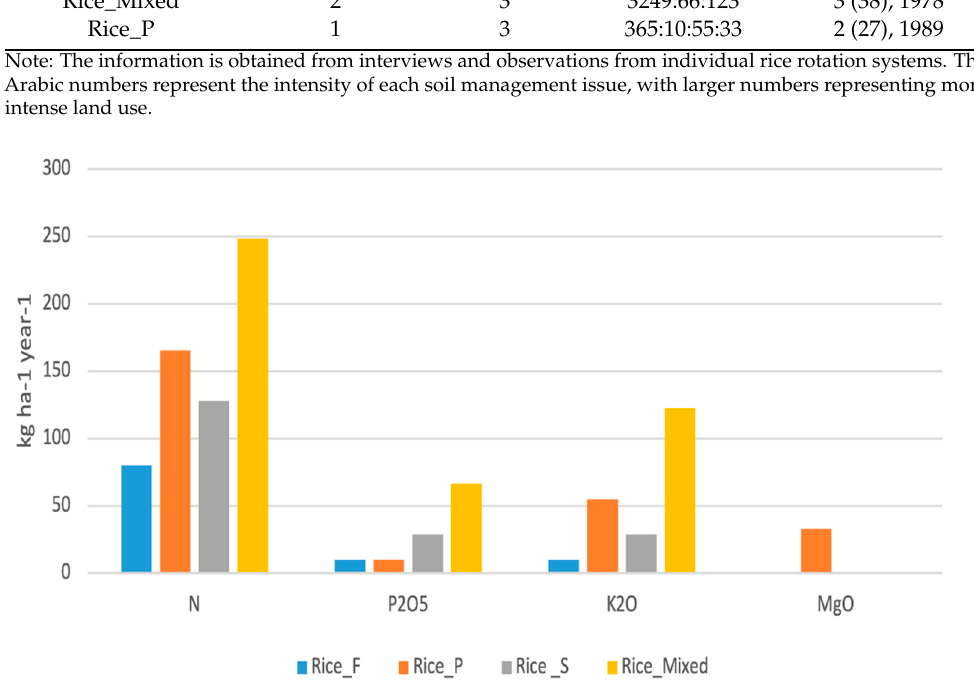
Rice Rotation Cropping System